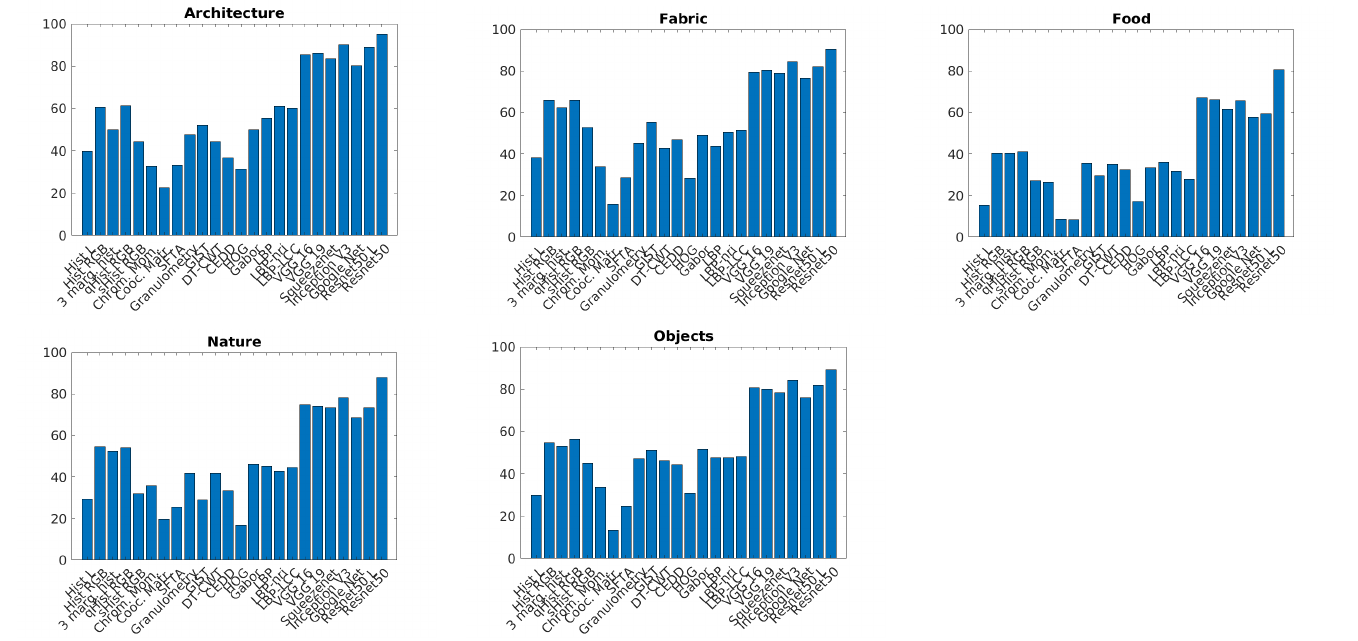
Figure 8. Visual descriptor comparison for each of the thematic